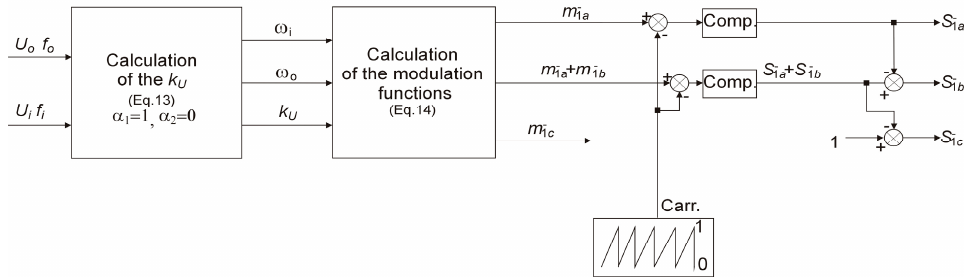
Figure 3. Block diagram of the currier based CCW modulation for output phase number “1”.